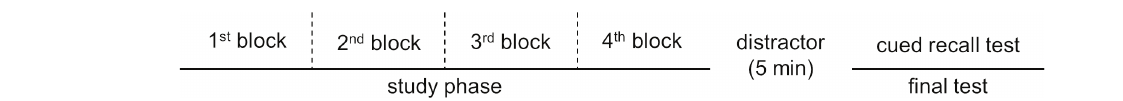
FIGURE 2 | Overall flow of Experiment 1.